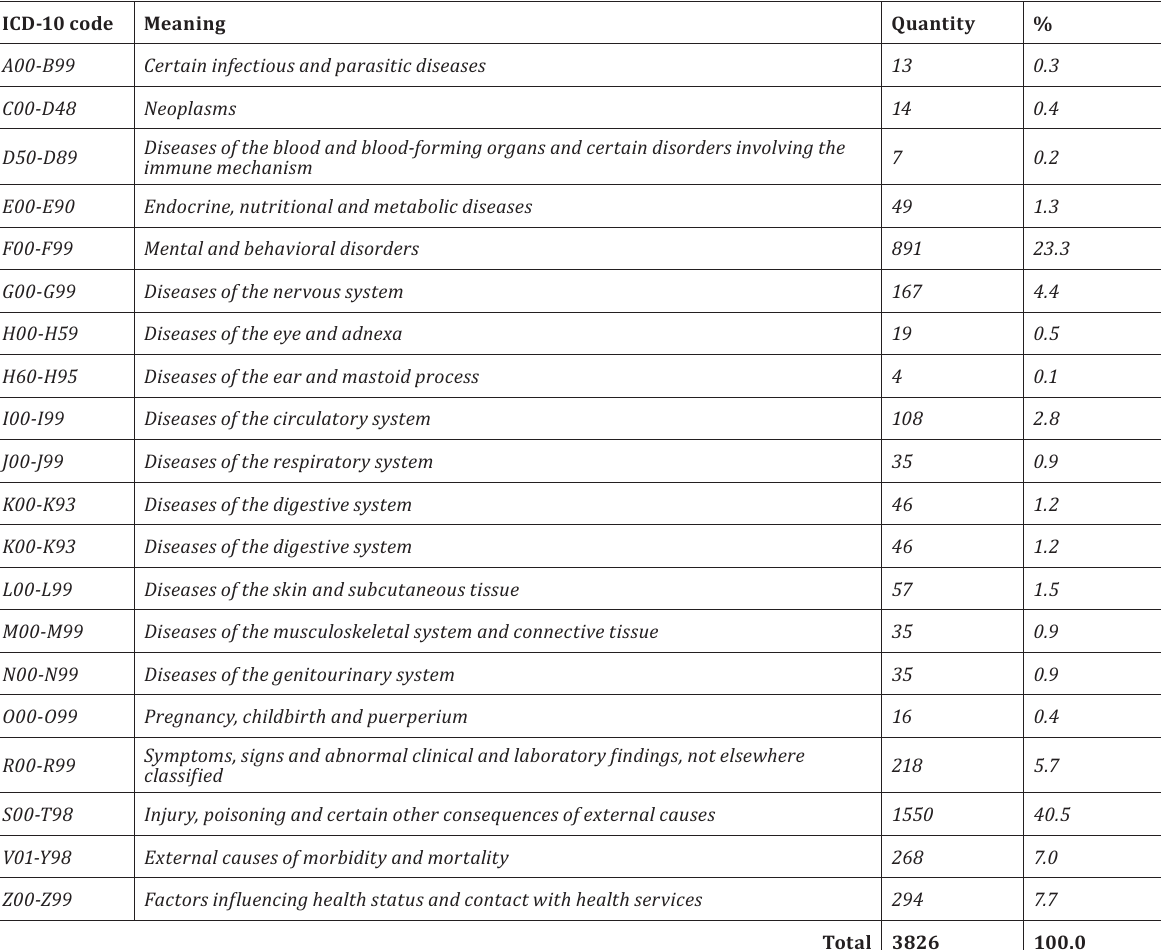
Table 2. Disease diagnoses according to ICD-10 code in homeless patients admitted to ED